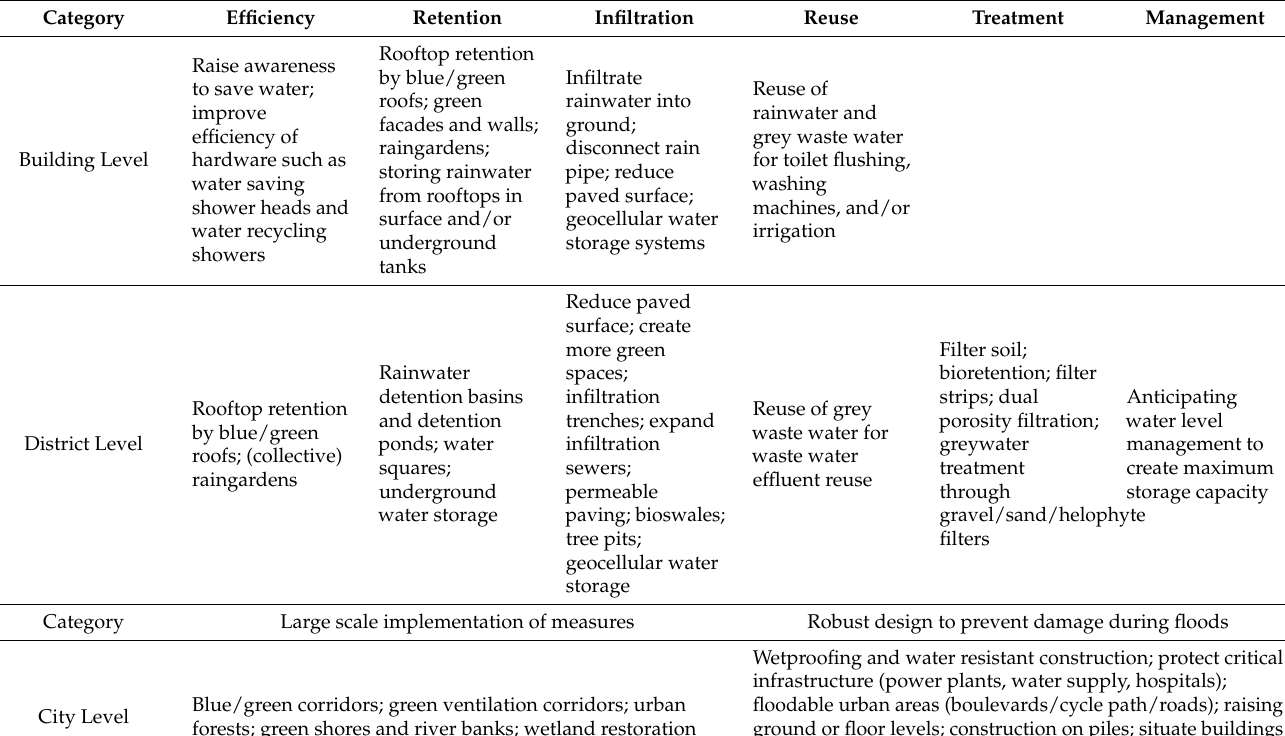
Table 2. Summary of possible measures in a water smart city as presented in